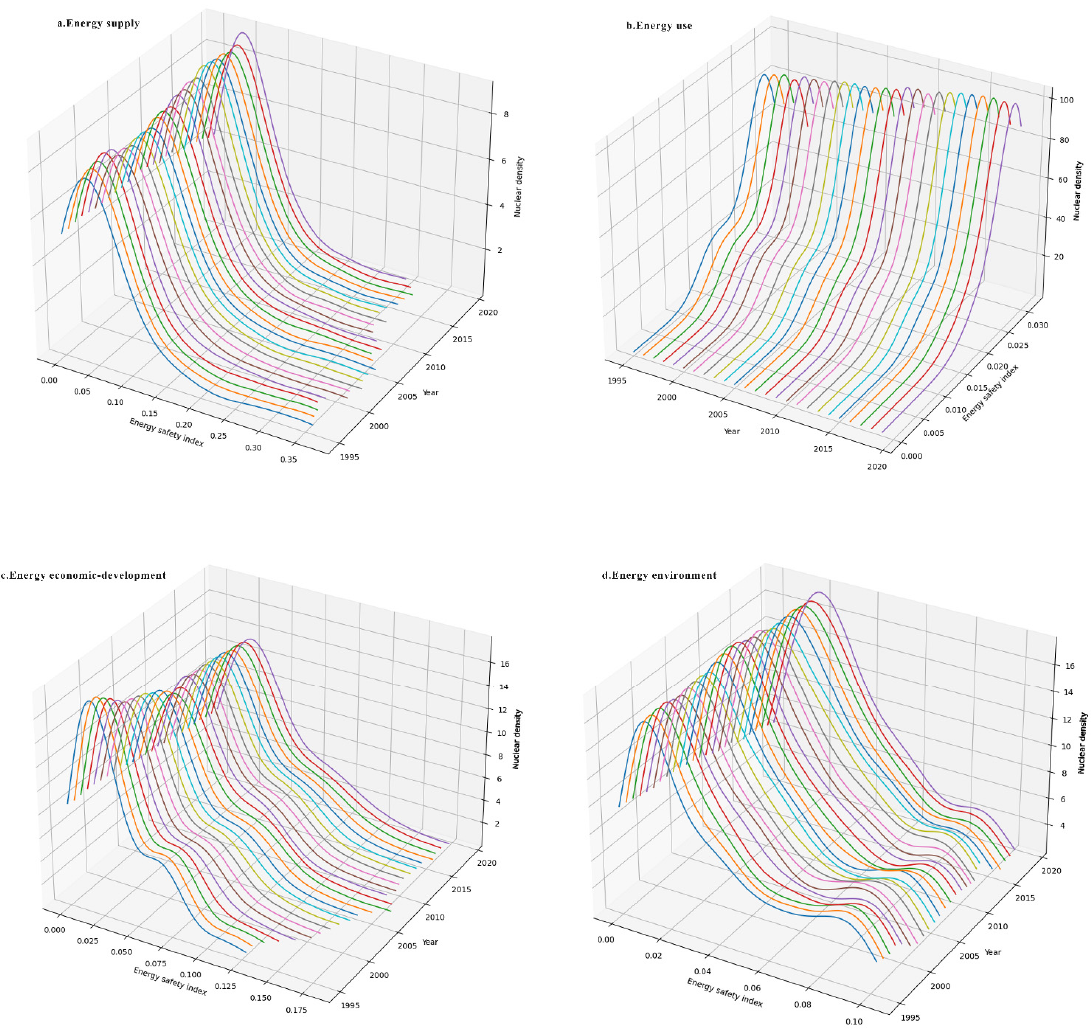
Figure 15. Evolution of energy security index in different dimensions.